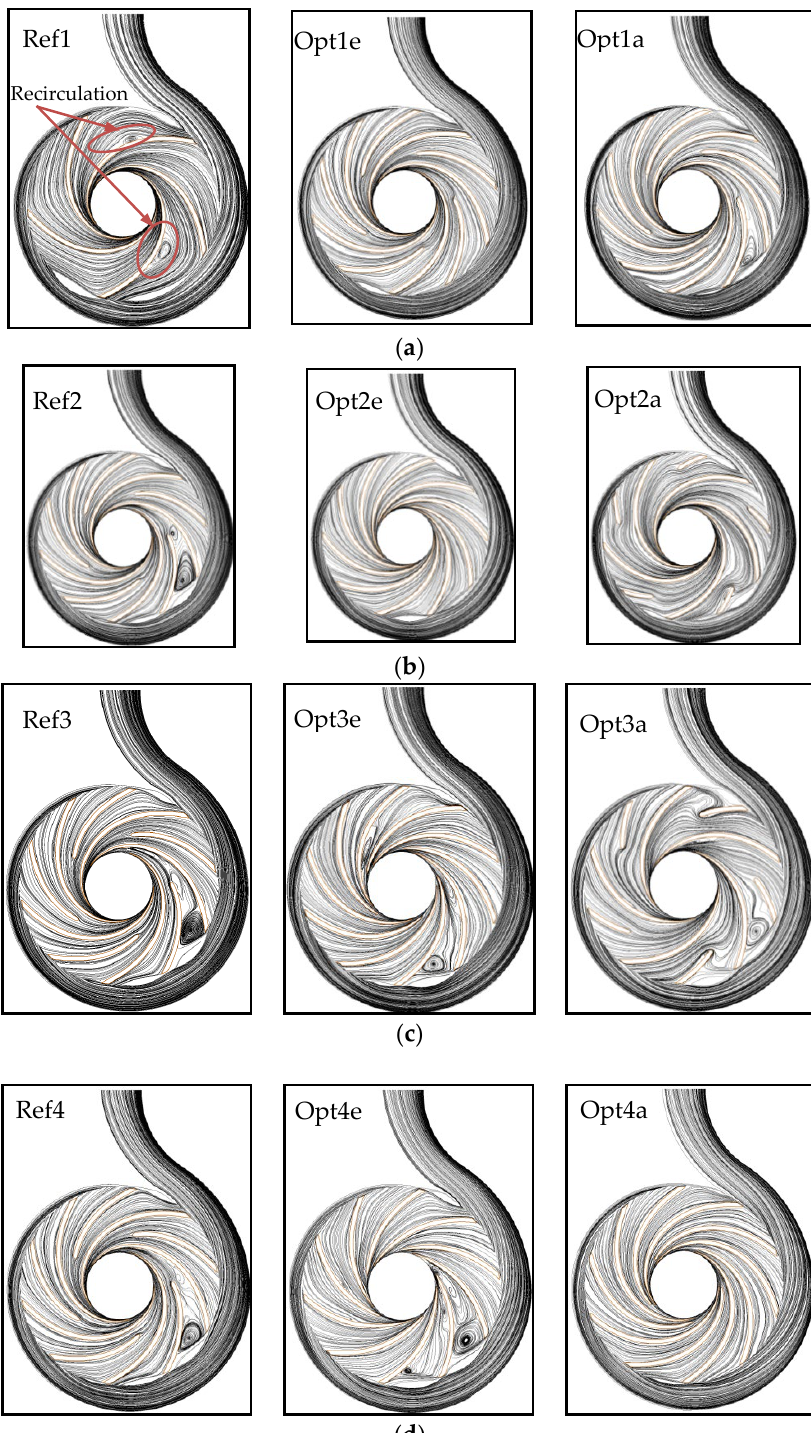
Figure 19. Streamline at the midspan of reference and optimized impeller for all cases: ( a ) water, C1, ( c ) C2, and ( d ) C3. ( b ) C1, ( c ) C2, and ( d )